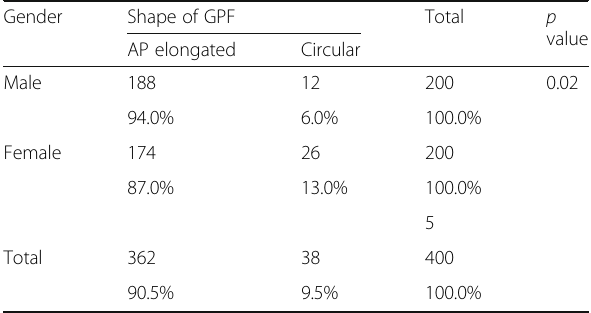
Table 8 Frequency and percent of the shape of the GPF based on